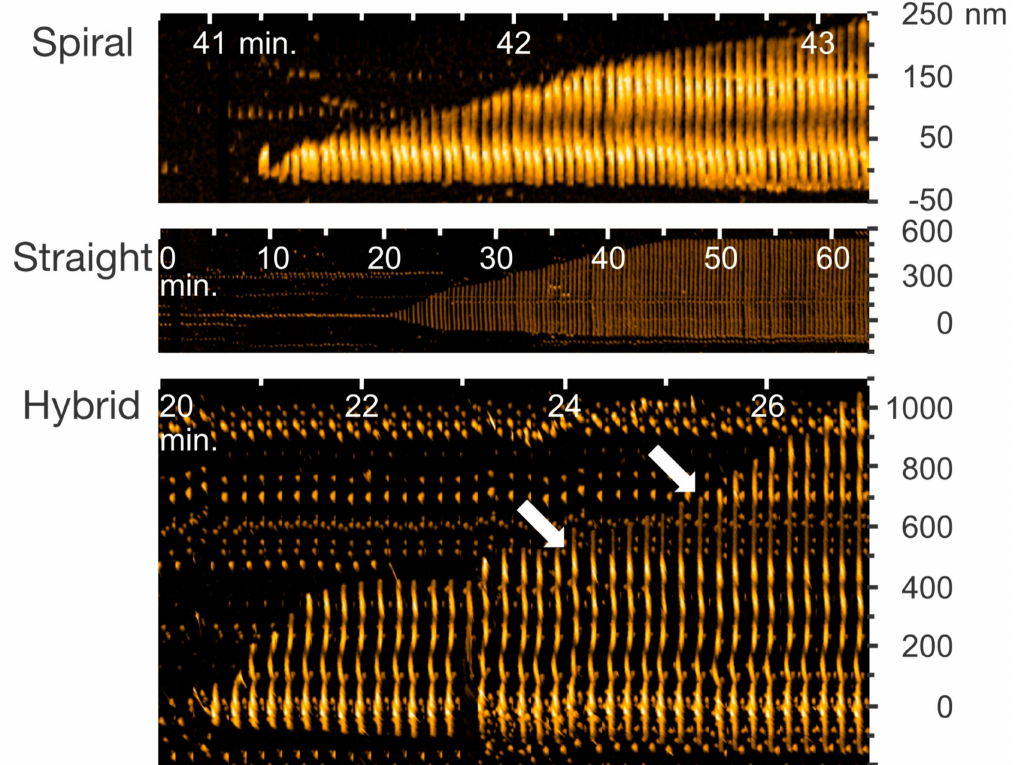
Figure 2. Kymographs of spiral, straight, and hybrid types of A β 42 fibrils from HS-AFM images of the indicated time ranges after addition of 0.1 M NaCl. Arrows indicate the positions at which the growth mode switched from the spiral to the straight at 24 min and from the straight to the spiral at around 25 min. Reproduced from